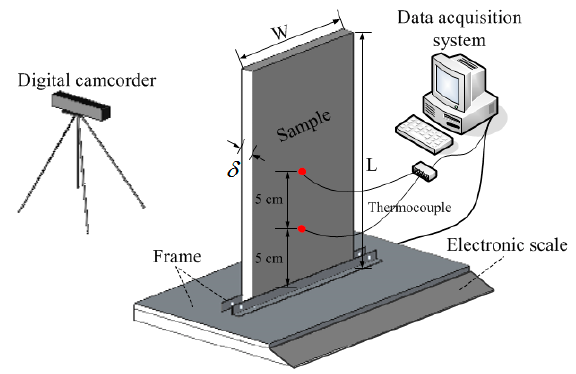
Figure 1. Schematic illustration of the experimental apparatus.